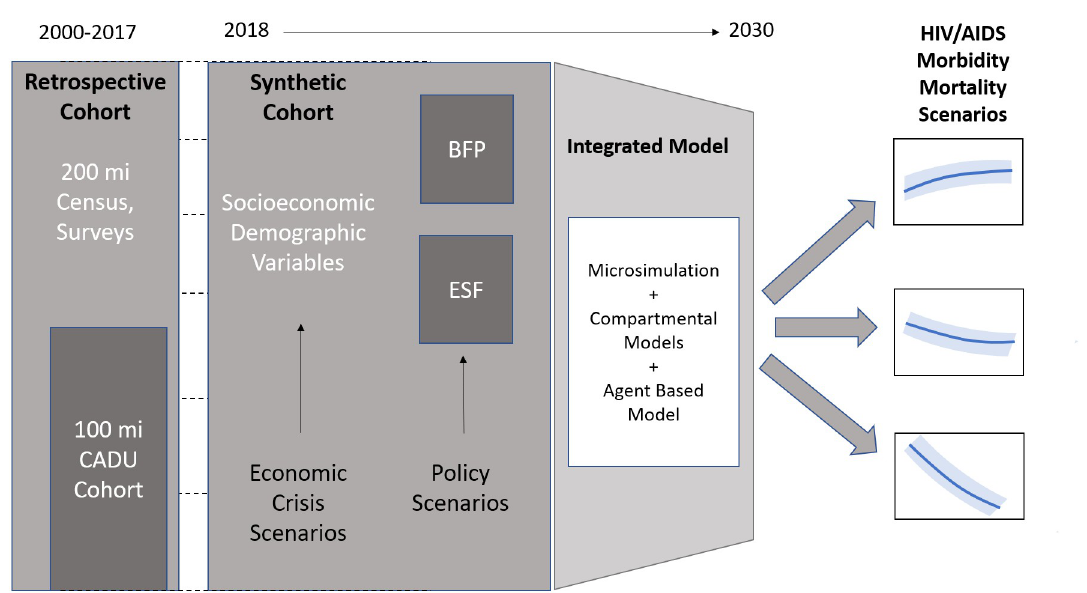
Fig 3. Integrated microsimulation, compartmental and agent-based